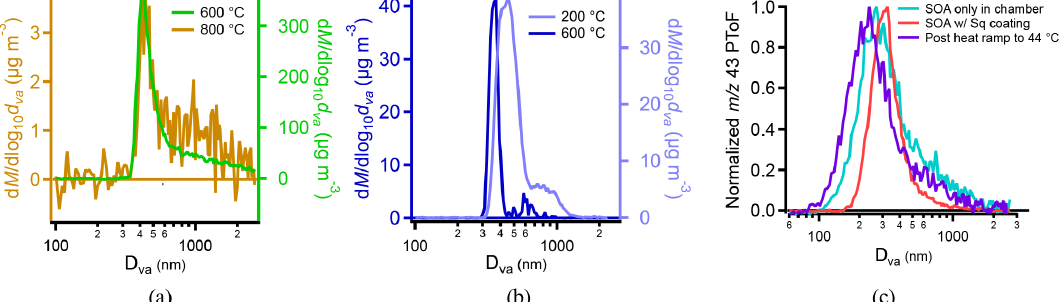
Figure 9. Ensemble mass distributions of different particle types. (a) Organic mass distributions for α -pinene-derived SOA particles at two different vaporizer temperatures with DMA-selected mobility diameter of 370nm: 600 (green) and 800 ◦ C (brown). Note: the degraded signal at 800 ◦ C is due to low particle numbers due to smog chamber wall loss, as these data were taken at the end of an experiment where particle number was relatively low. (b) m/z 46 PToF mass distributions for DMA-selected mobility diameter of 300nm at the standard vaporizer temperature (600 ◦ C, dark blue) and low temperature (200 ◦ C, sky blue). (c) m/z 43 mass distributions from SOA particles at three stages of a mixed-particle experiment: homogeneously nucleated SOA (teal), SOA particles coated with d 62 -squalane (red), and SOA/ d 62 -squalane particles after an increase in chamber temperature (purple). Note the disappearance of the delayed tail with the condensation of d 62 -squalane and the reappearance of the tail with heating despite the decrease in mode diameter.